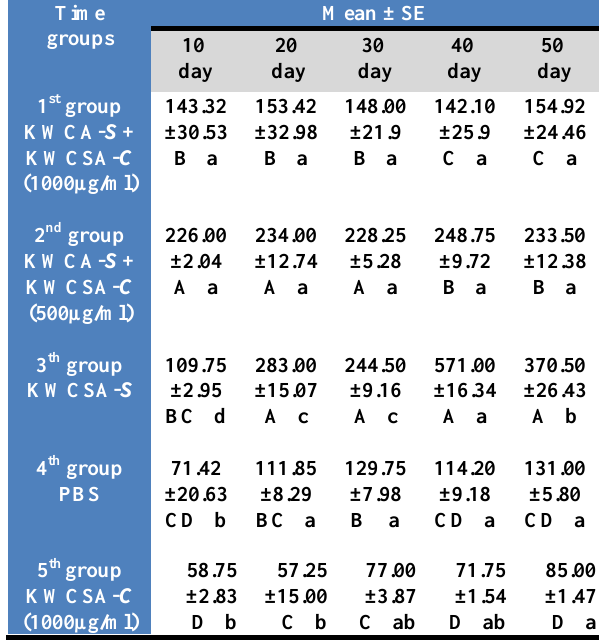
Table, 3: IL-8 concentration (Pg) in white rats immunized by killed whole cell Salmonella enterica subspecies typhimurium and sonicated whole cell Cryptococcus neoformans